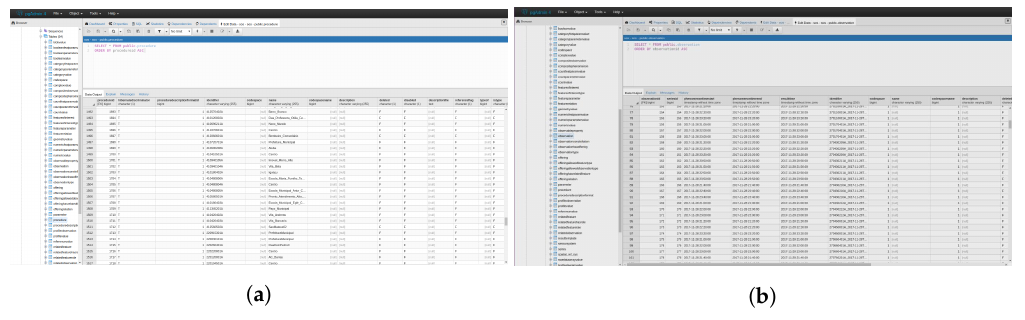
Figure 22. SOS repository. ( a ) Procedure table; ( b ) Observation table.